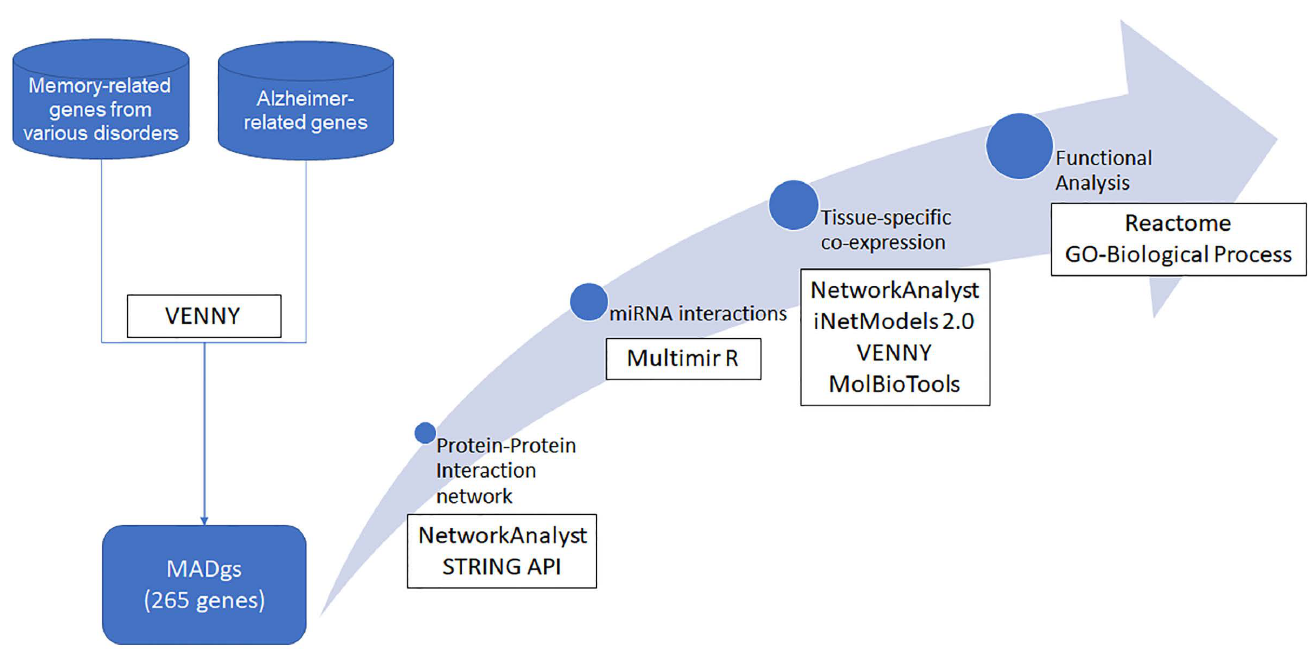
Figure 1. Visual representation of the methodological steps taken. Rectangles with a white back- ground encase the tools